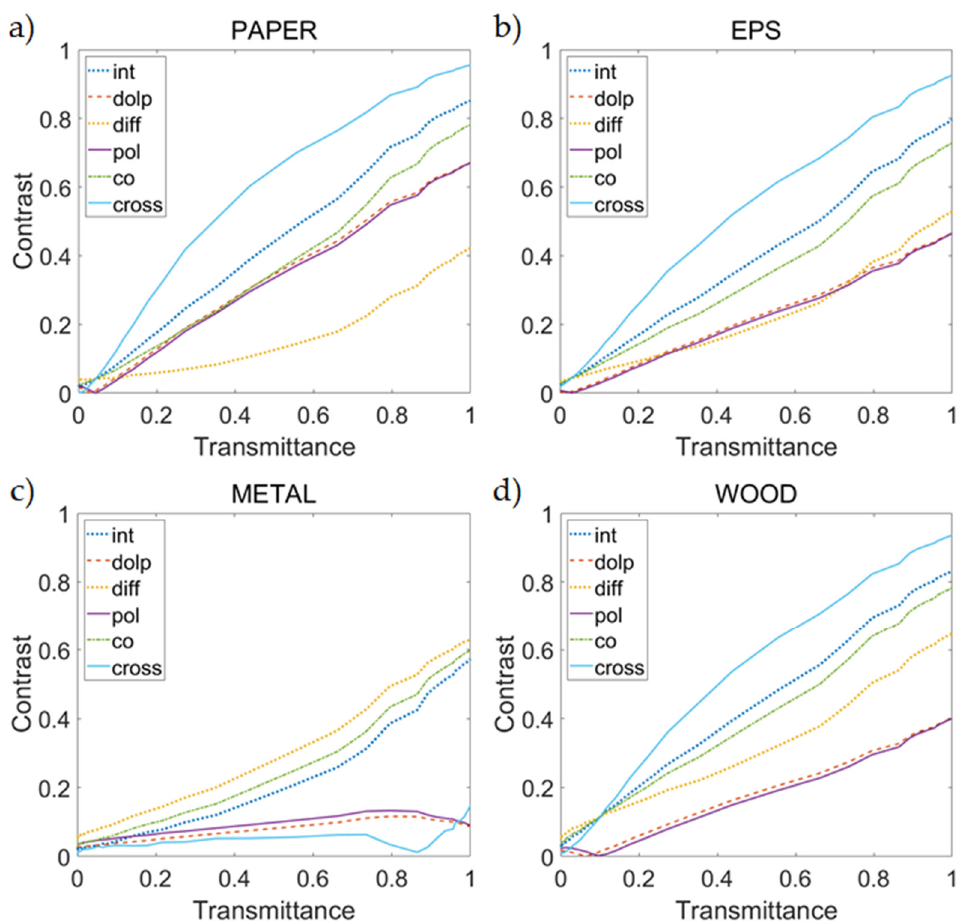
Figure 7. Michelson’s contrast obtained for the image modes described in Table 4, at different transmittances. Each subfigure shows the result for different materials: ( a ) paper, ( b ) EPS, ( c ) metal, and ( d ) wood.